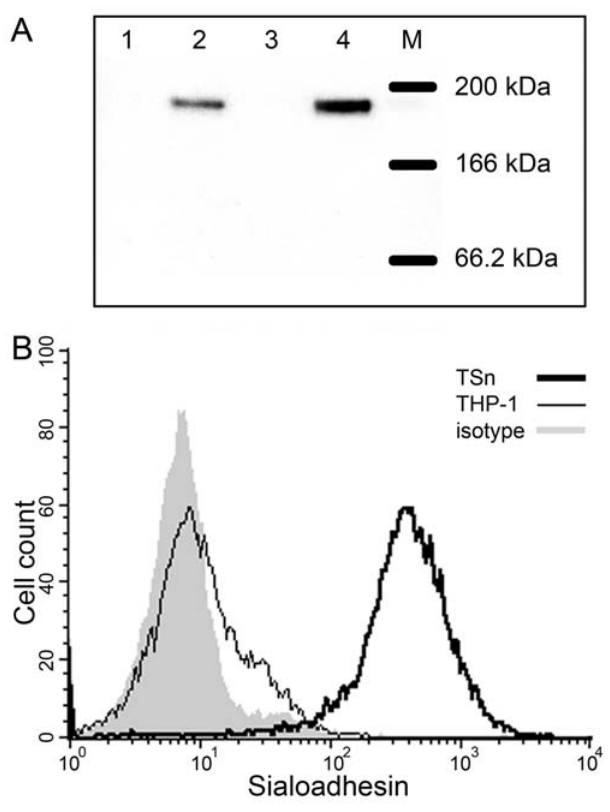
Figure 3. Constitutive Sn expression in THP-1 by gene transduction (TSn). (A) Immunoblot analysis of Sn protein expression. THP-1 cell line was transduced with a plasmid encoding Sn cloned downstream of the high-level constitutive promoter CMV. Cell lysates were standardized, reduced with DTT and 10 m g of protein were loaded into each well: monocytes (lane 1), IFN- a -induced monocytes (lane2), THP-1 (lane 3) and TSn (lane 4) (M, molecular size marker). (B) Histogram of relative distribution of Sn on the cell surface of TSn clone. TSn (thick black line) and THP-1 cells (thin black line) were evaluated for Sn expression by flow cytometry using anti-Sn mAb 7D2 relative to the background isotype-matched control mAb (shaded region). doi:10.1371/journal.pone.0001967.g003 infected [21]. TZM-bl cells, which are permissive to HIV-1 NL4-3 infection, express the viral receptor CD4 and coreceptors CCR5 and CXCR4. When THP-1 cells were pulsed with concentrated HIV-1 NL4-3 stock for 1 h, washed extensively to remove